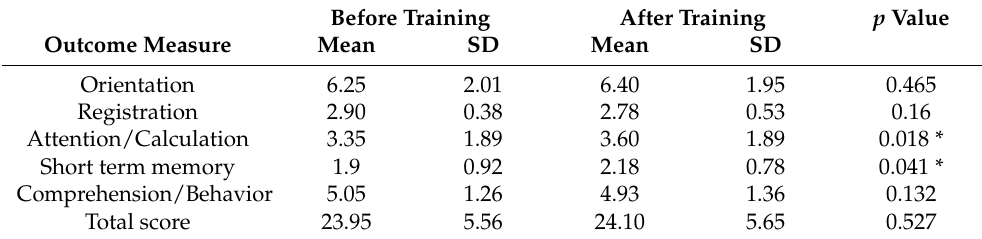
Table 2. MMSE before and after 4 weeks cycling wheelchair training.